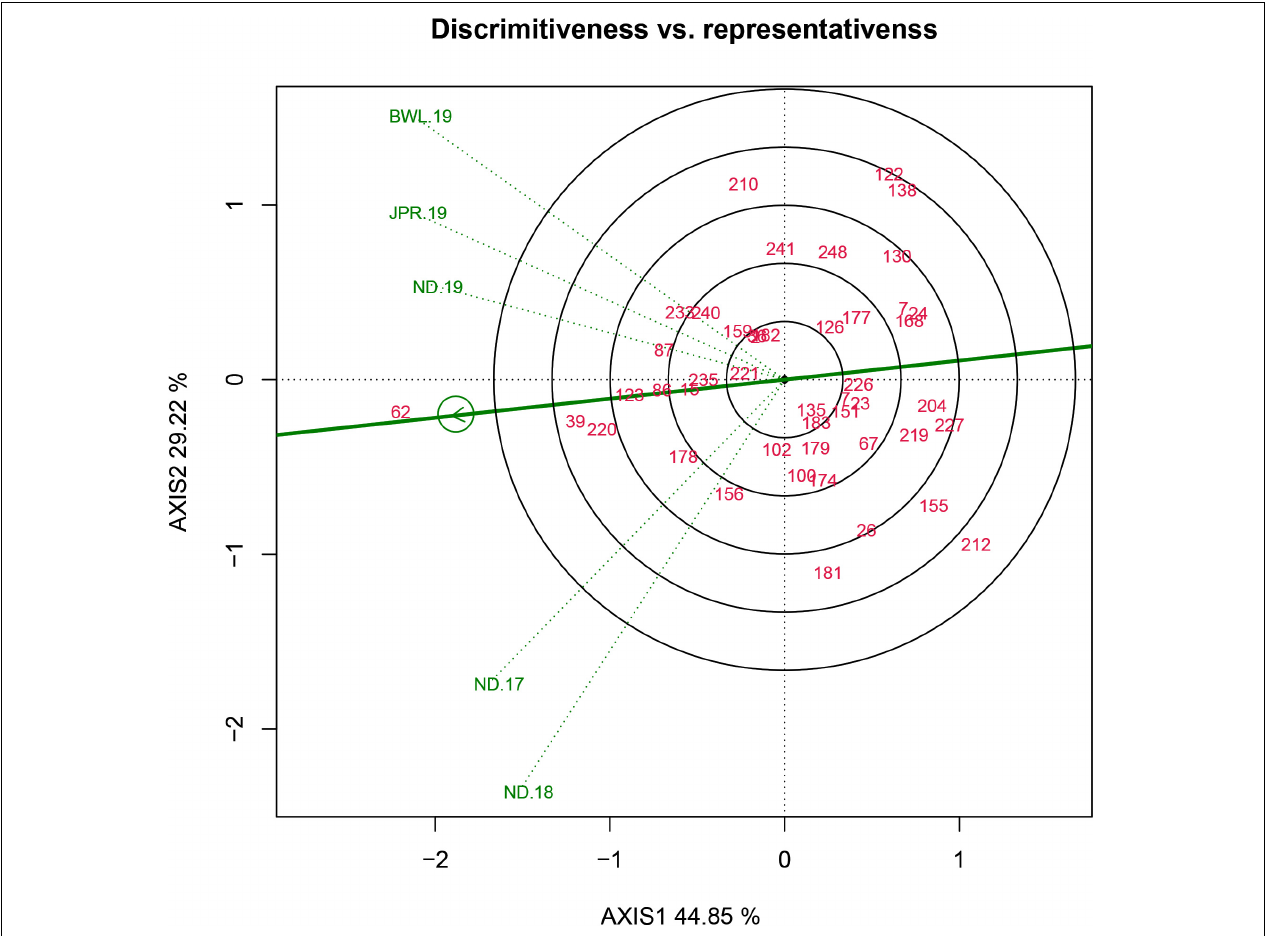
FIGURE 8 | Discriminativeness vs representativeness view of test locations based on GGE biplot of 43 resistant genotypes across five testing environments. There was heritability-adjusted scaling of data where the environment standardized data were multiplied by the heritability in each environment (transform = HA), and data were centered by means of the environments (centering = 2). The biplot was based on “Column metric preserving.” Numbers correspond to genotypes as listed in Supplementary Table 1 . Environment: ND-17, New Delhi-2017; ND-18, New Delhi-2018; ND-19, New Delhi-2019; BWL-19, Bawal-2019; JPR-19,